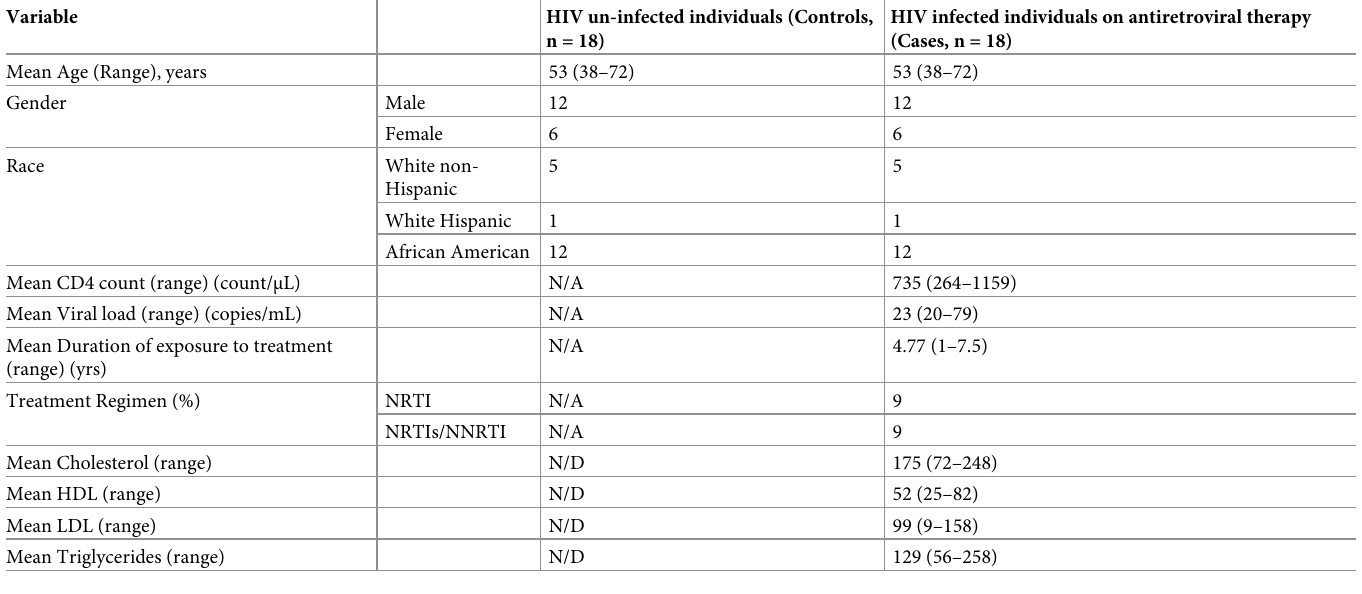
Table 2. Demographic and clinical characteristics of study